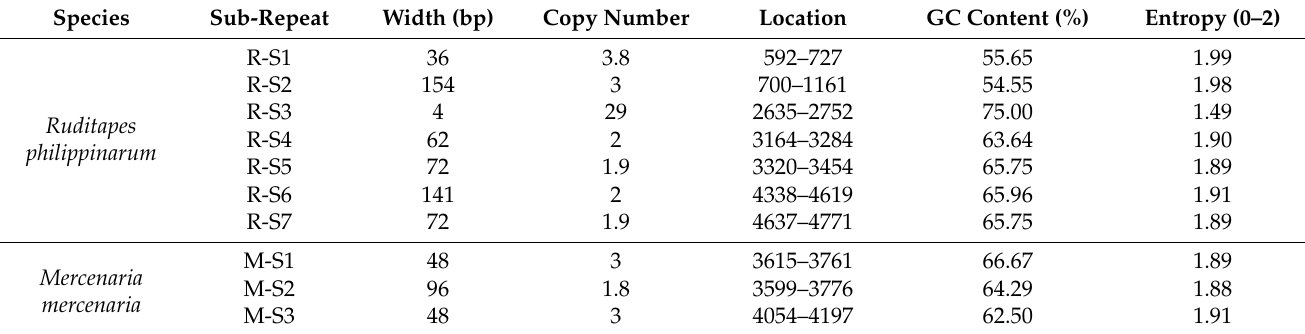
Table 4. Characterisation of repeated regions defined for R. philippinarum and M. mercenaria . Species